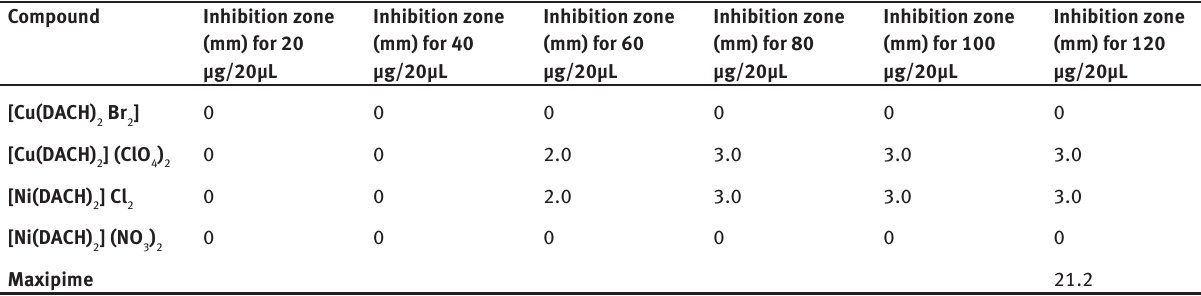
Table 5: Results of antibacterial activity of the coordination complexes of DACH against Escherichia coli. Compound